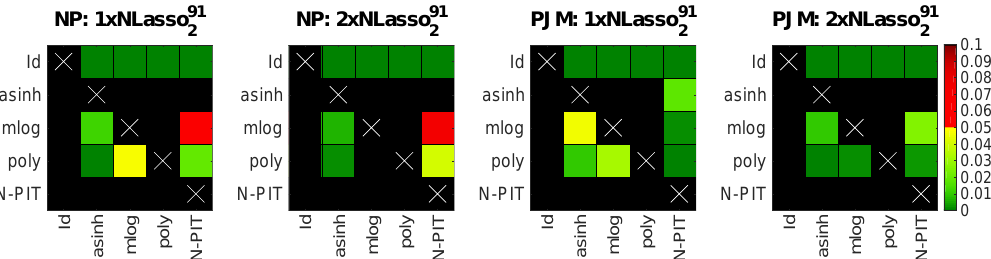
Figure 6. Results of the ‘multivariate’ DM test for the best performers in Table 1 (i.e., 1xNLasso 91 2xNLasso 91 ) for Nord Pool ( two left panels ) and PJM ( two right panels ) across the VSTs. Like in Figures 4 2 and 5, a heat map is used to indicate the range of obtained p -values for the pairwise